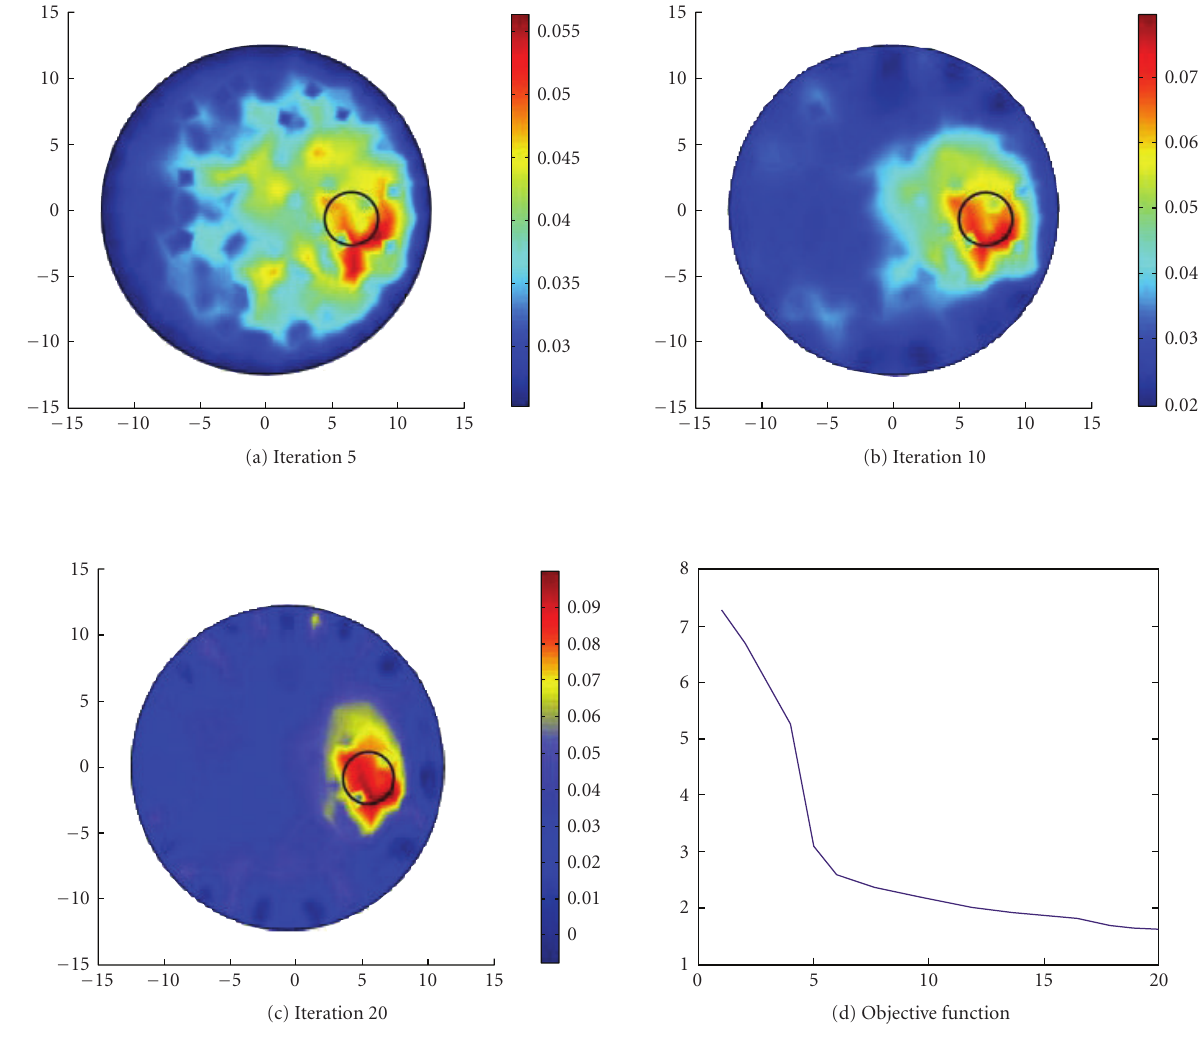
Figure 8: Reconstruction